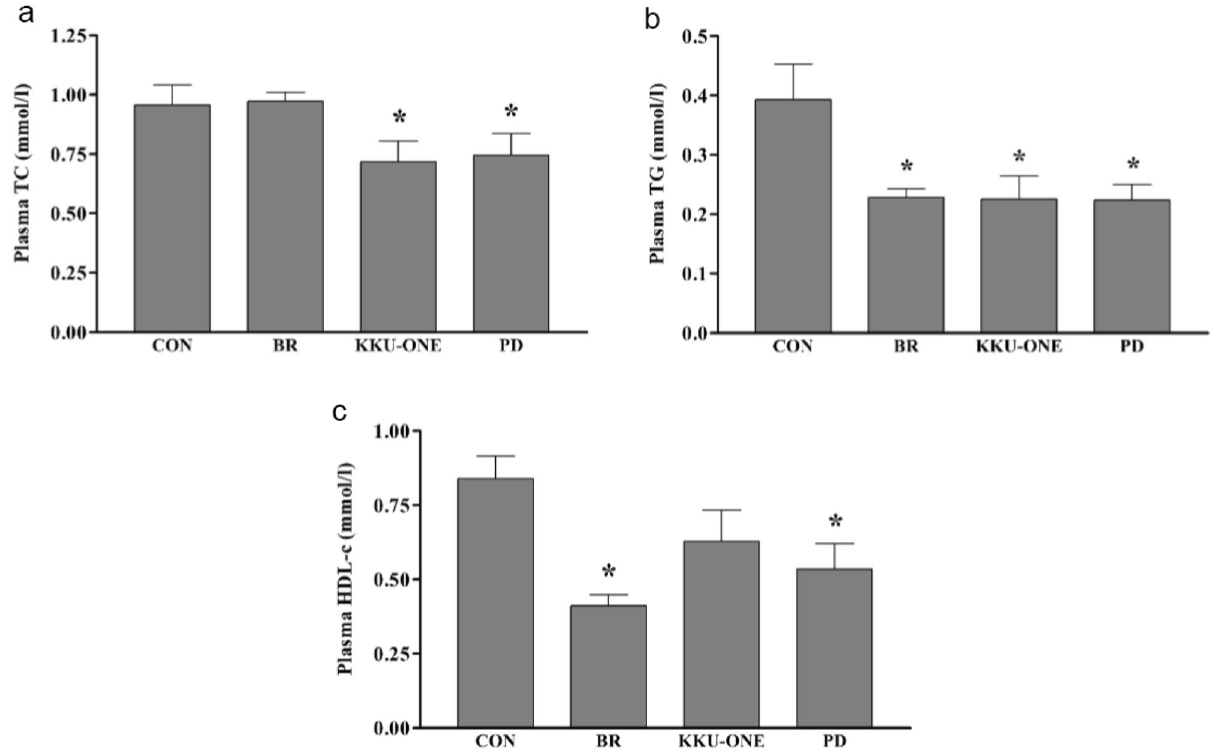
Figure 1. Effect of high protein chicken breast meat diet on plasma ( a ) TC, ( b ) TG, and ( c ) HDL-c in rats. Data are expressed as means ± SEM. (n = 6–8 animals/group); * p < 0.05 vs. CON; TC: total cholesterol, TG: total triglyceride, HDL-c: high-density lipoprotein cholesterol; BR, commercial broiler group, CON, control group, KKU-ONE, commercial broiler × Thai native crossbred group, PD, Thai native chicken (Pradu Hang Dam)